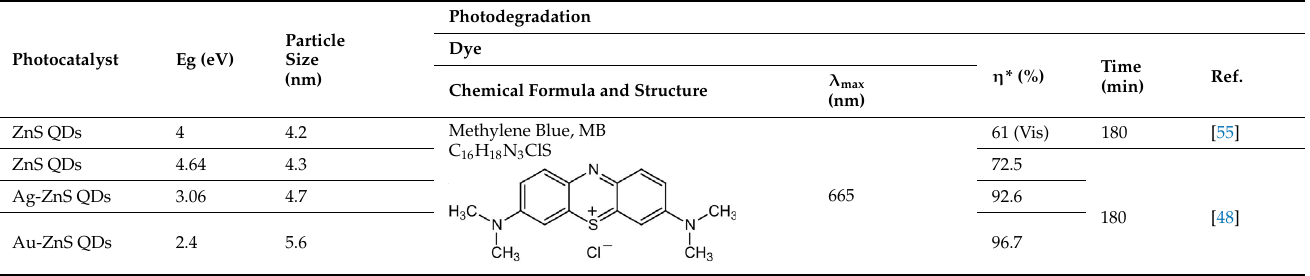
Table 2. The structural, optical, and photocatalytic properties of undoped and metal-doped ZnS QDS’ photocatalysts.